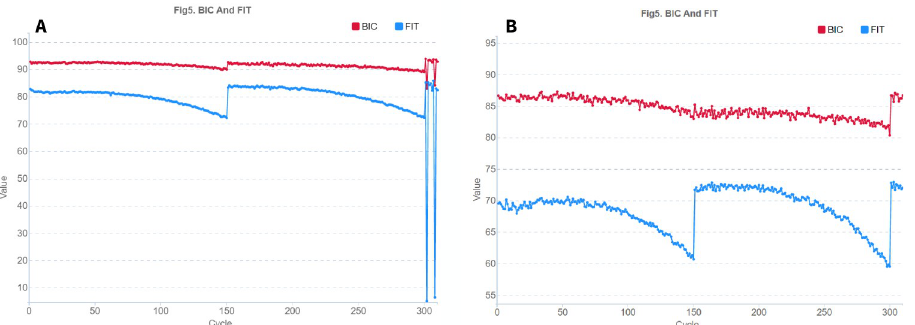
Fig 3. Example of a single lane FIT graph for a PE150 run on an MGISEQ-2000 with a non-optimal (A) and optimal (B) set of barcodes. Sequencing cycles corresponding to the sequence number of the nucleotide in the reads are shown horizontally: 1:150 –forward read, 151:300 –reverse read, 301:310 –bar code sequence, vertically–FIT (blue) and BIC (red) indicators which mean the probabilities or reliability of the base call results. A drop in the FIT graph at the positions of nucleotides, where the barcodes of different samples cannot be identified correctly.